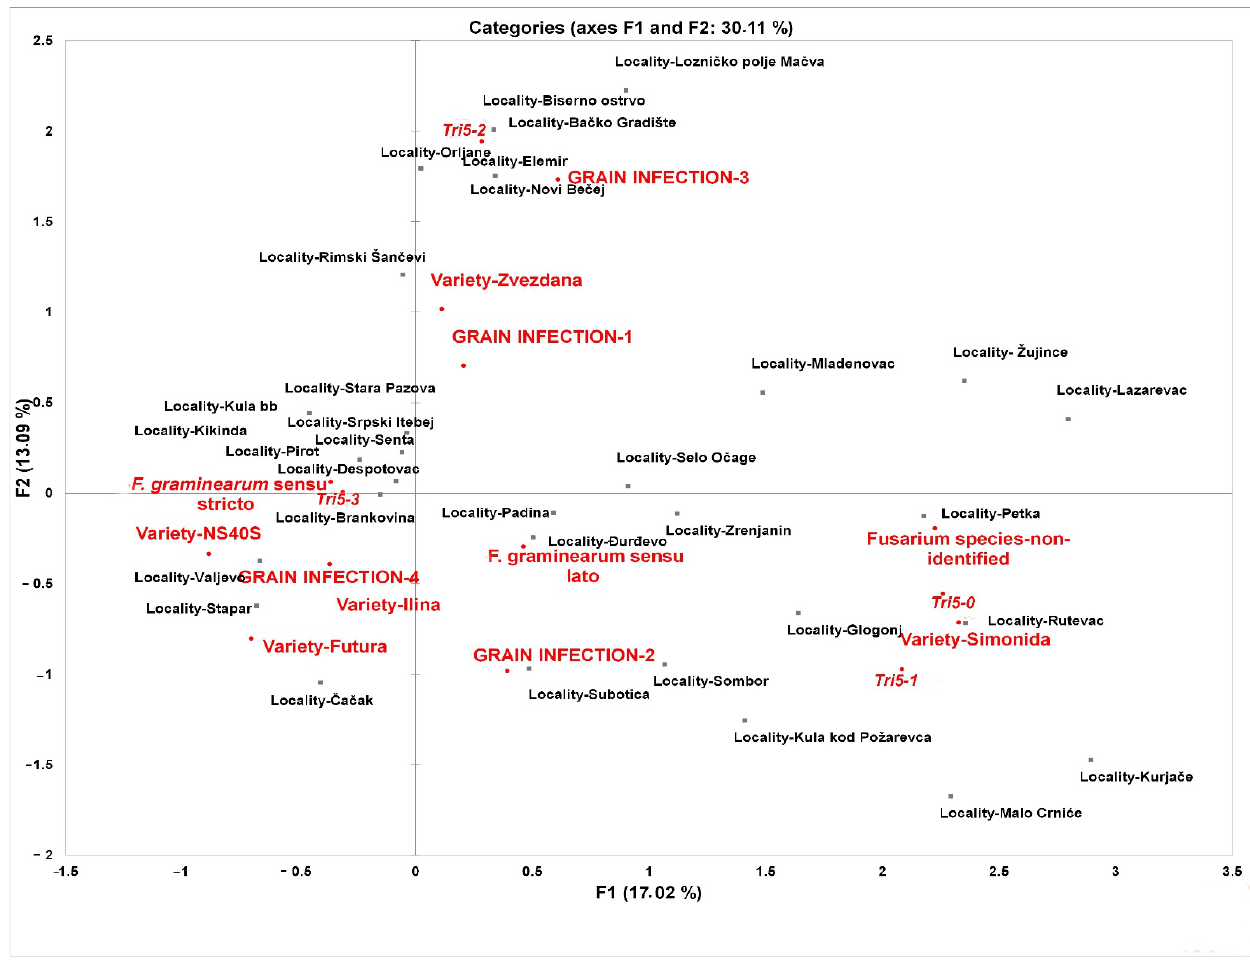
Figure 6. Graphic representation of multiple correspondence analysis (MCA) between grain infection, location, variety, mycotoxin production predisposition of the FGSC, and the presence of F. graminearum s. stricto, F. graminearum s. lato, and nonidentified (FGSC) isolates.